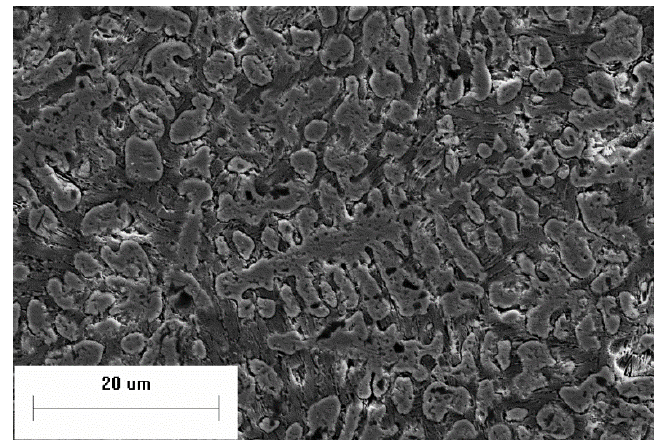
Figure 6. Powder microstructure ( d = 280 μ m).